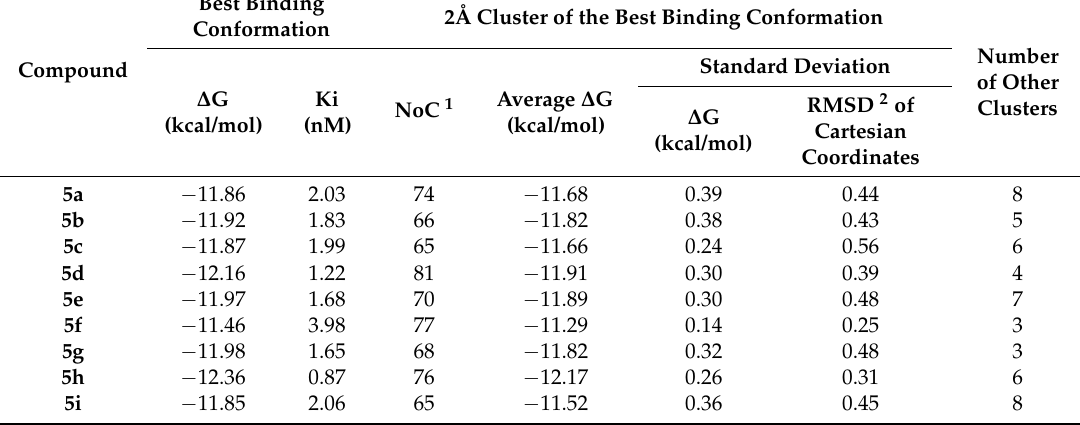
2Å Cluster of the Best Binding Conformation